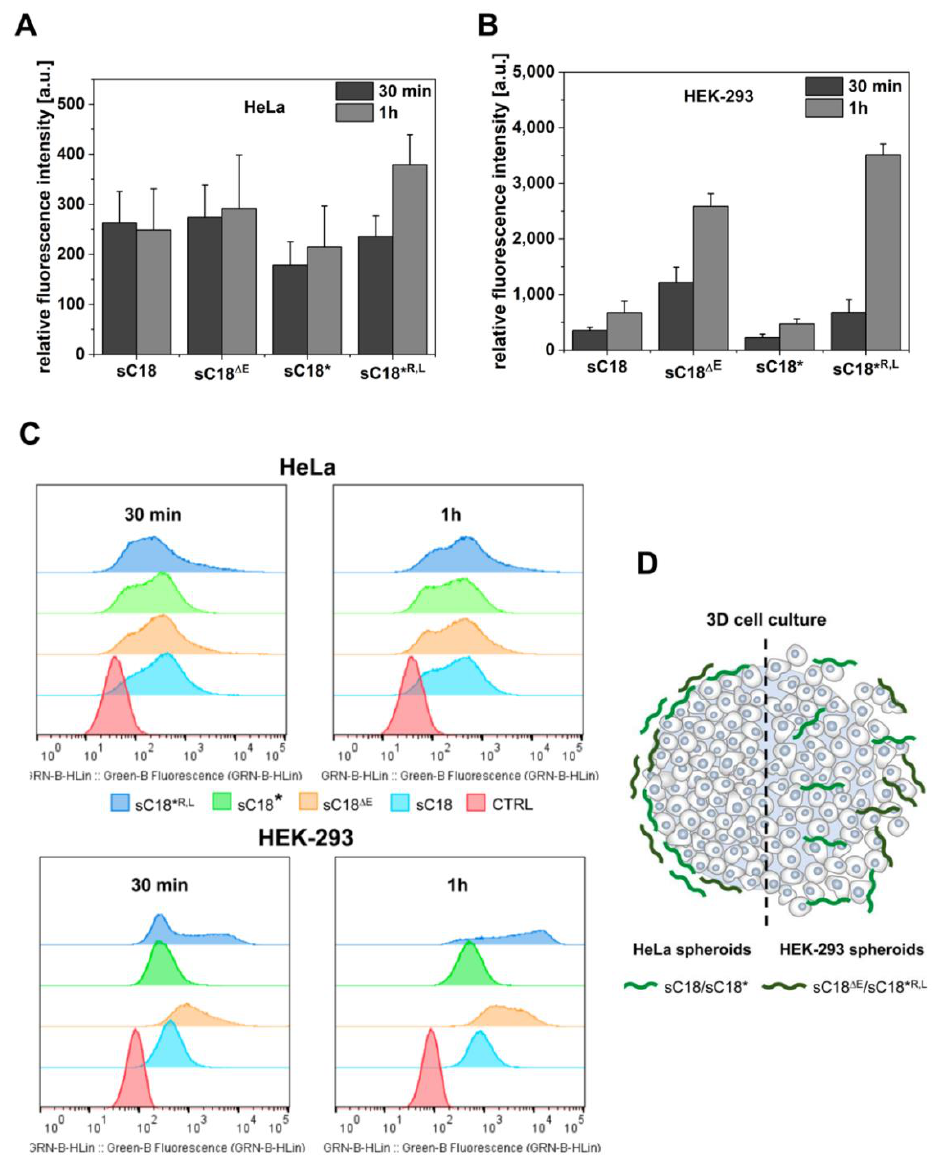
Figure 3. ( A ): Flow cytometry analysis of HeLa spheroids that were incubated with 10 µ M CF-labeled sC18 variants for 30 min and 1 h, respectively. ( B ): Flow cytometry analysis of HEK-293 spheroids that were incubated with 10 µ M CF-labeled sC18 variants for 30 min and 1 h, respectively. ( C ): Distribution profiles for HeLa and HEK-293 spheroids after 30 min and 1 h incubation time. All experiments were conducted in triplicate with n = 4. ( D ): Proposed distribution profile of sC18-variants in tumor spheroids. Left: Accumulation of sC18-variants in HeLa spheroids. Right: Distribution of sC18-variants in HEK-293 spheroids [35].